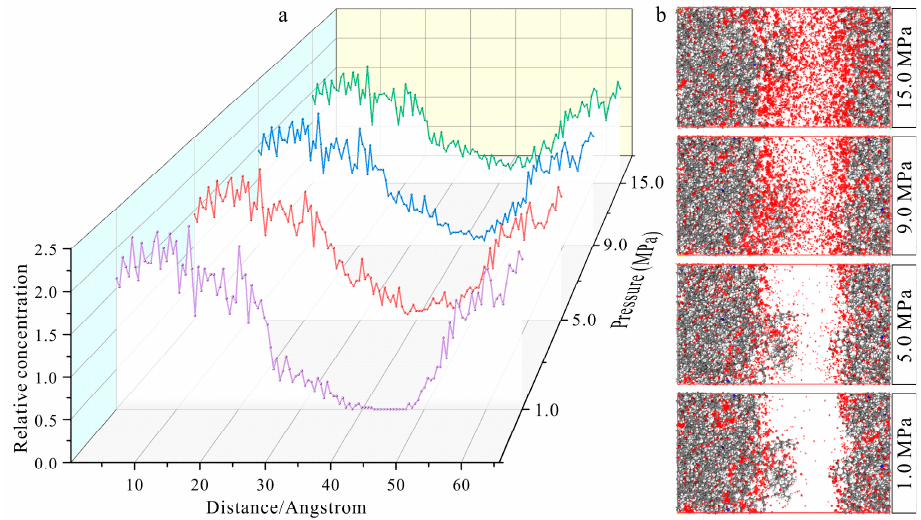
Figure 9. ( a ) The relative concentration distribution of CH 4 in the coal model along the z-axis at different pressures.; ( b ) Snapshot of CH 4 molecules (red dots) concentration distribution in coal model at different pressures.